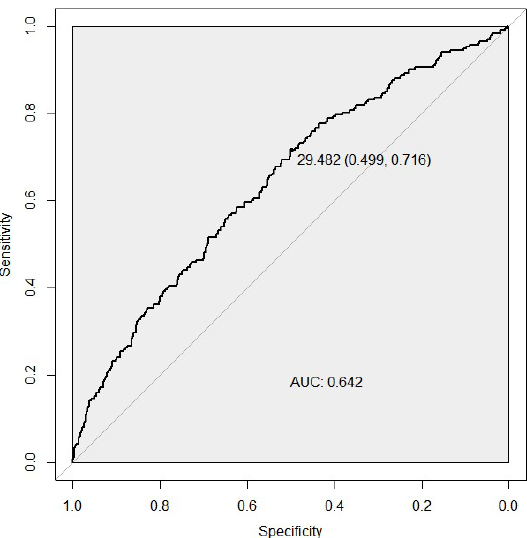
Figure 1. ROC curves assessing the discriminative power of the weighted PGS model for the ccRCC risk. The best predictive point is shown with the ideal cut-off for the PGS and with estimates for specificity and sensitivity at that point. AUC, area under the curve.